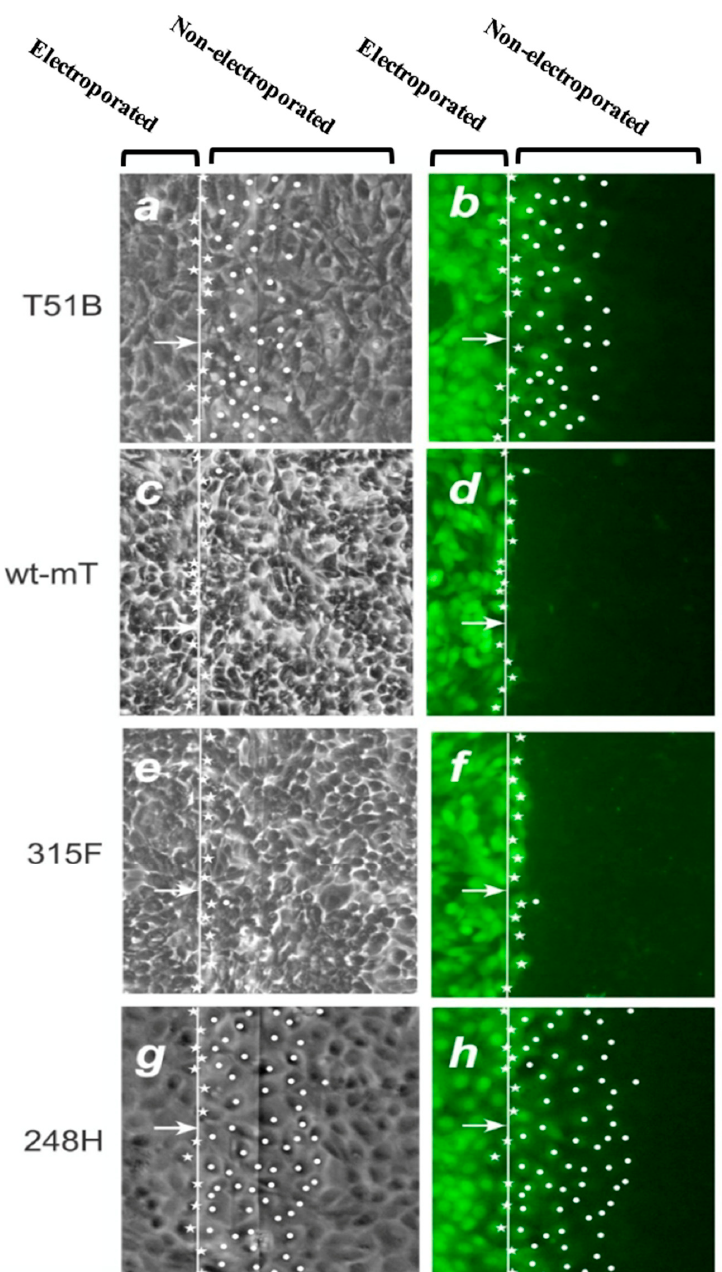
Figure 1. GJIC in T51B rat liver epithelial cells and derivatives expressing wt or mutant mT. GJIC was examined using a technique of in situ electroporation: The indicated cell lines were grown on a glass slide, part of which is coated with a thin layer (~800 Å) of electrically conductive and transparent Indium-Tin oxide, as shown at the top. The fluorescent dye, Lucifer yellow (LY) was added to the cells and introduced via an electric pulse which causes the formation of “pores” on the plasma membrane. The migration of LY to the neighboring, non-electroporated cells through the cells’ gap junctions is observed under fluorescence illumination ( b, d, f, h ) and offers a quantitative measure of GJIC (reviewed in [59]). ( a, c, e, g ): Phase-contrast images of the same fields. Stars indicate cells loaded with LY by electroporation. Dots denote cells where LY has penetrated through gap junctions. Arrows point to the edge of the electroporated area. Magnification: 240x. Note the extensive GJIC of T51B-248H cells. (From [31], reproduced with permission).